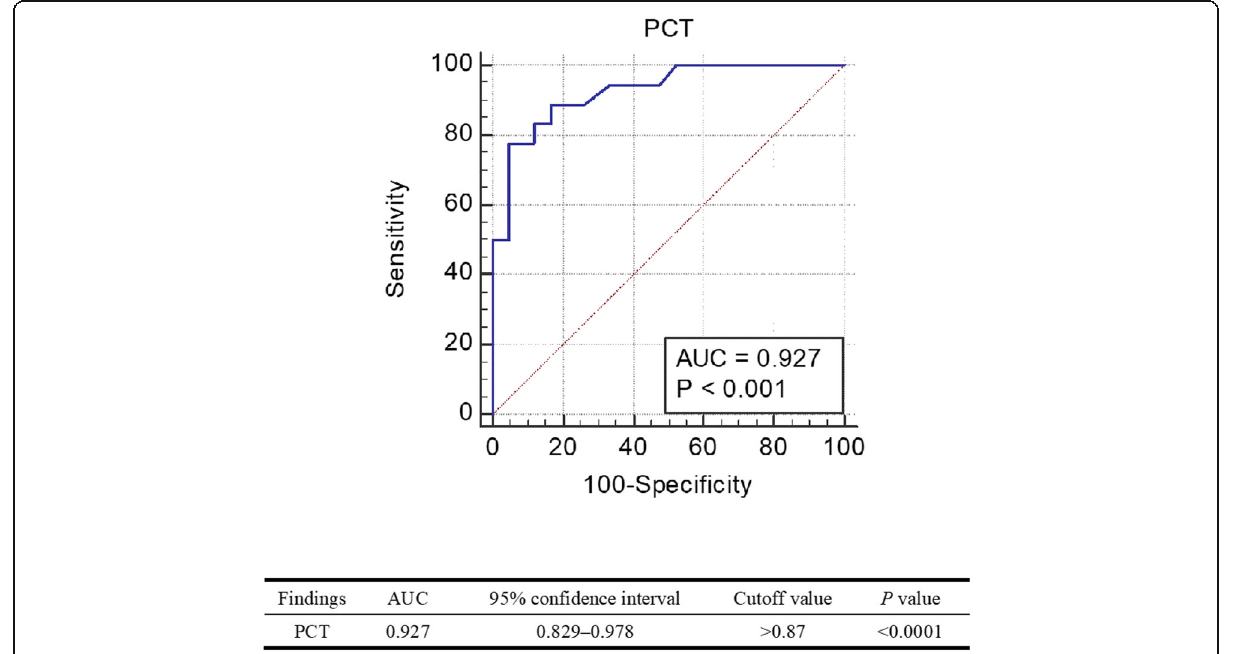
Fig. 1 Sepsis syndrome receiver operating characteristic curves for procalcitonin test (95% confidence